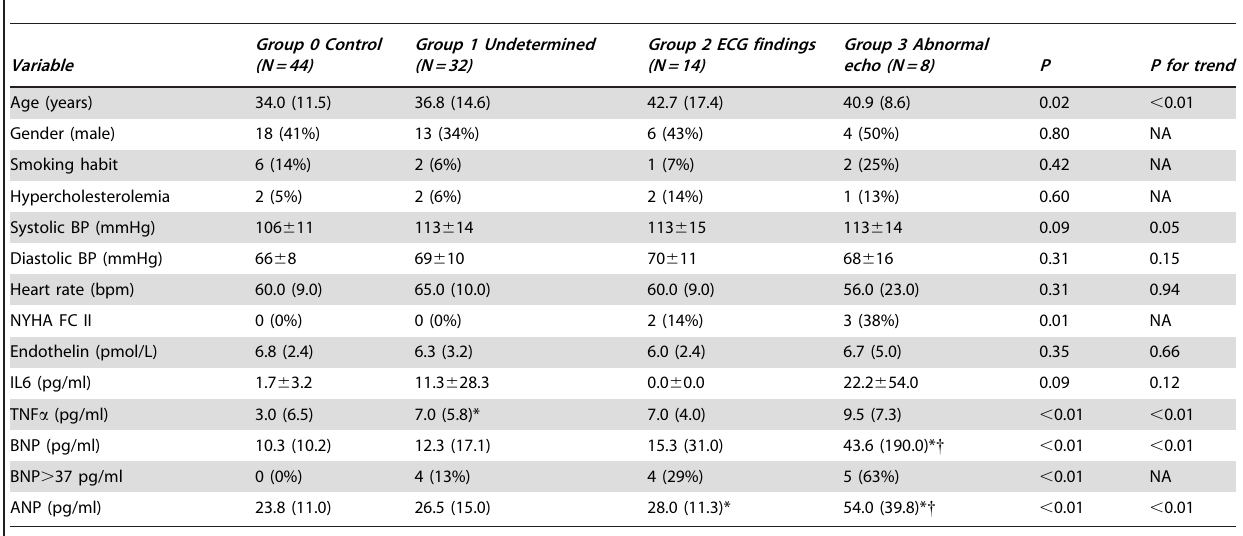
Table 1. Demographic and hemodynamic characteristics and blood markers of control individuals and patients in the undetermined and cardiac